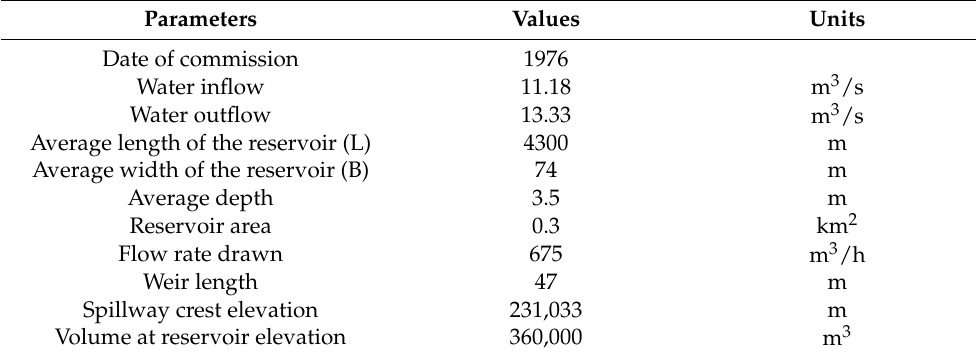
Table 1. Characteristics of the Lobo Reservoir.